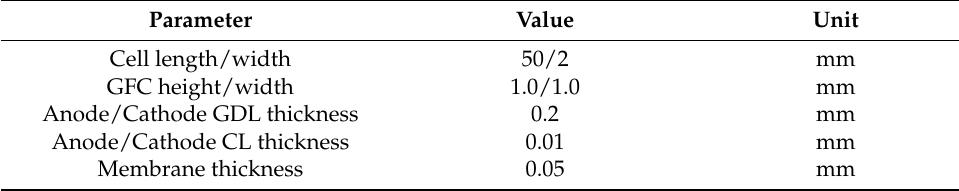
Figure 1. Schematic of a single fuel cell and the computational domain. Table 1. Geometric parameters of the computational domain.